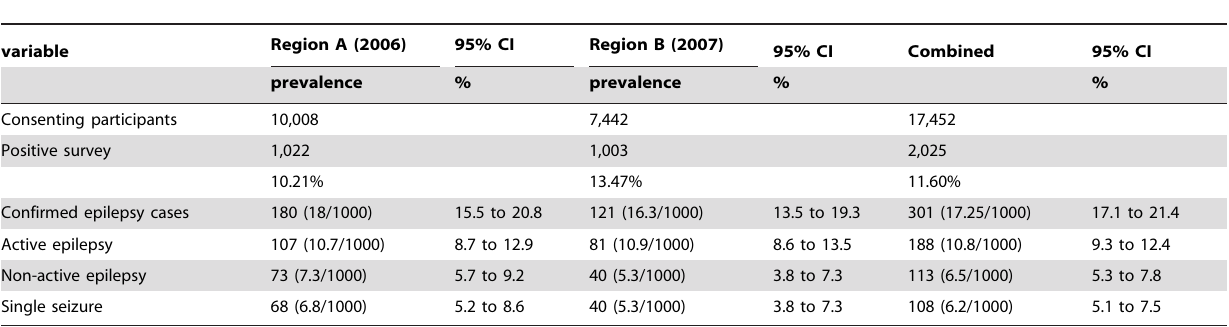
Table 2. Prevalence’s of epilepsy and seizures in the studied